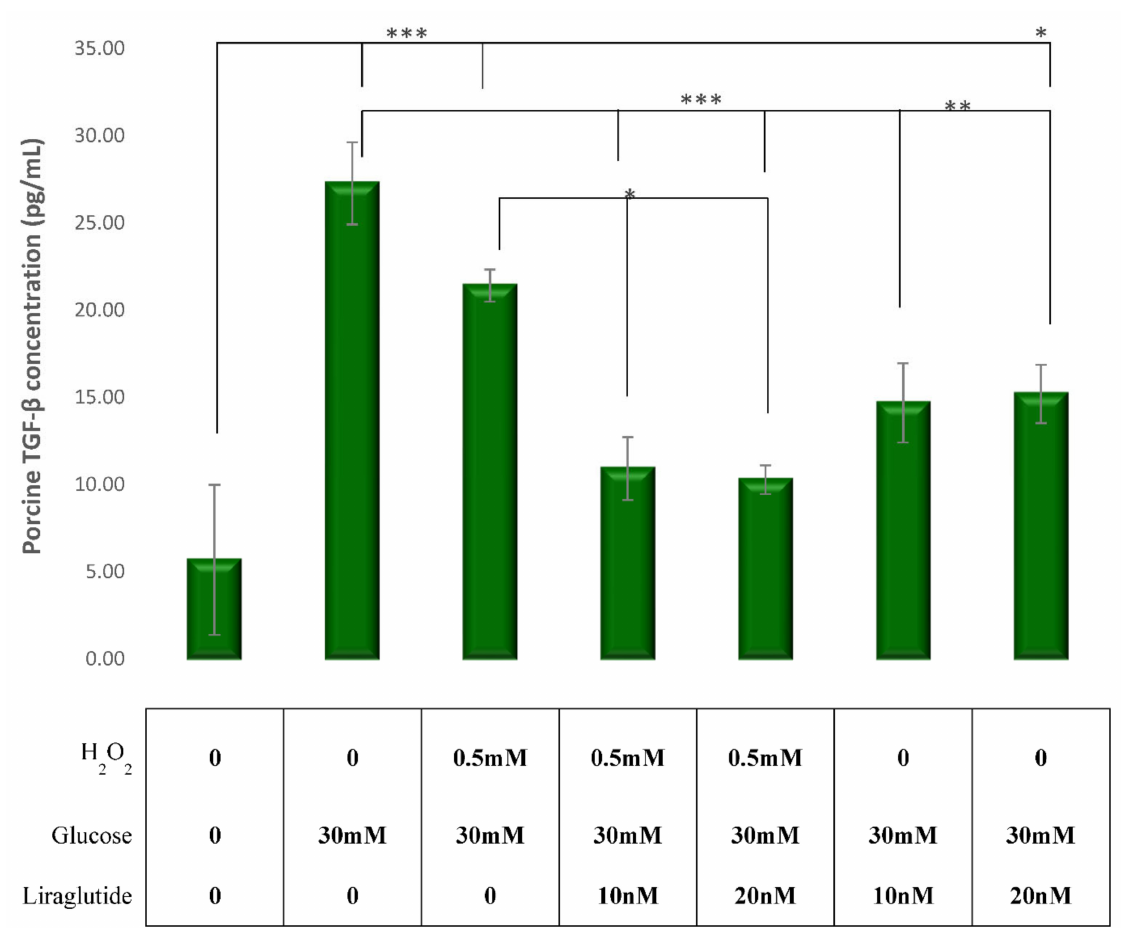
Figure 3. Levels of TGF- β concentrations in the experimental LLCPK1-treated cell lines (con- trol vs. HG30 and HG30/H 2 O 2 ; HG30 vs. HG30/Lira10 and HG30/Lira20; HG30/H 2 O 2 vs. HG30/H 2 O 2 /Lira10 and HG30/H 2 O 2 /Lira20). TGF- β measurements were done by spectrophotom- etry at 450 nm. One-way ANOVA F(7,23) = 14.54, p = 7.47 × 10 − 6 with Tukey HSD post hoc test; * p < 0.05, ** p < 0.01, *** p < 0.001. The values are represented in picogram per milliliter as average. Values underneath the x axis represent the amount of compound added in the experiment, and 0 represents that the compound was not added. The data are shown as the means ± SD (standard deviation) from three independent biological replicates. TGF- β Elisa, pig proximal tubule cell line (LLC-PK1), HG (1.5 mM, 30 mM), H 2 O 2 (0.5 mM), Liraglutide (10 nM, 20